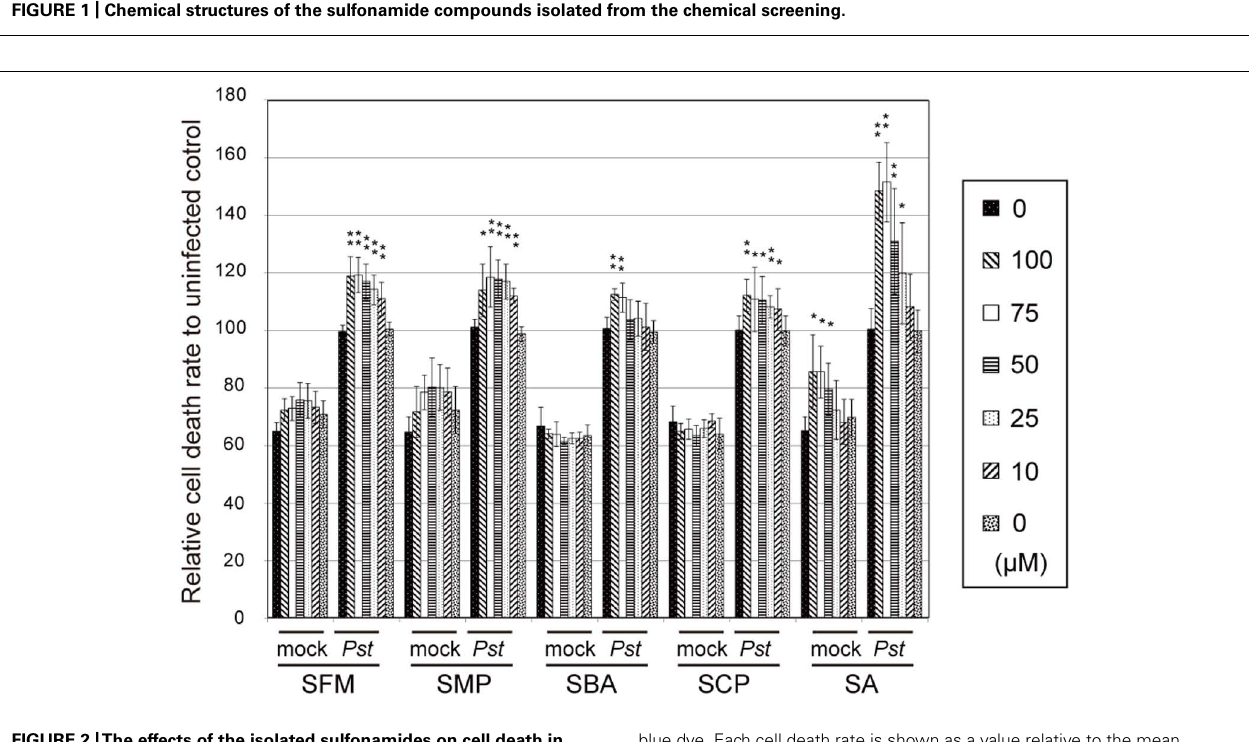
blue dye. Each cell death rate is shown as a value relative to the mean for the mock pathogen-treated group. SA was used as a positive control. The error bars represent mean ± SE values of four independent replicates. ** P < 0.01; two-tailed Student’s t test with post hoc Bonferroni’s